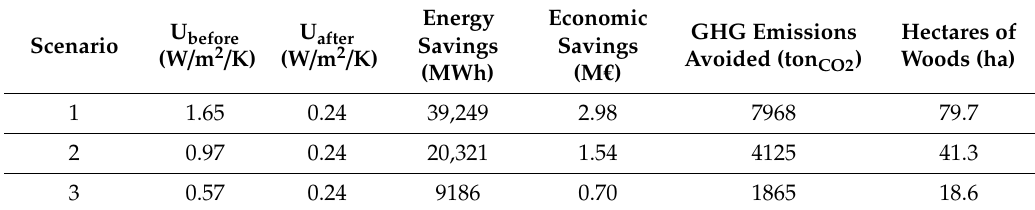
Table 12. Energy, economic and emissions savings with green